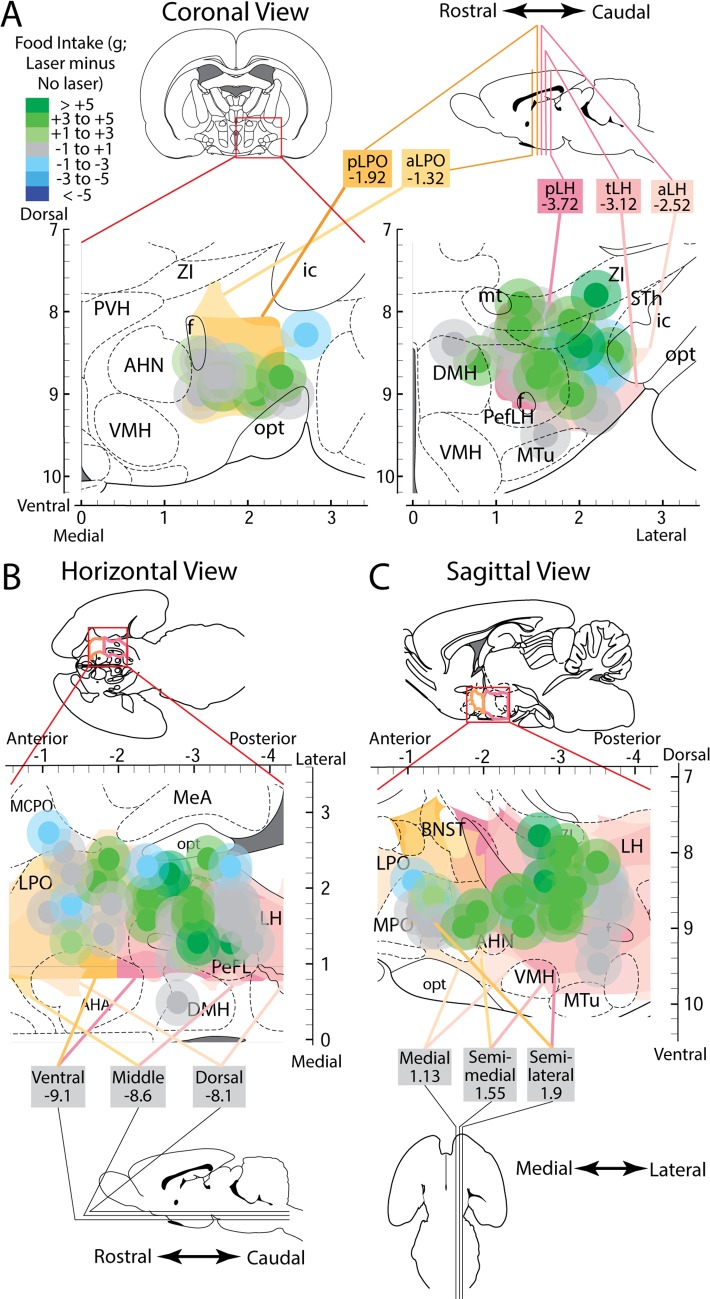
Fos/Jun plumes and associated laser-mediated food intake intensities localized to stereotaxic atlas maps.Placements were localized in along the AP axis to the LPO (A, left) and LH (A, right), along the ML axis (B), and along the DV axis (C). Different anatomical levels within these axes were topographically layered and colored to show levels of the LPO in shades of orange and levels of LH in shades of pink. Plumes were colored to show magnitude of behavioral laser-elicited food intake change versus baseline intake levels, with outer plumes made translucent.